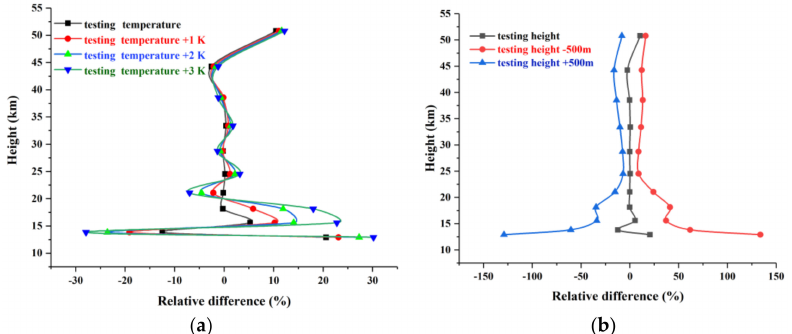
Figure 8. Relative differences between retrieval results and ACE-FTS NO 2 product under different temperature errors and different tangent height errors. ( a ) Relative differences between retrieval results and ACE-FTS NO 2 product under the conditions of exact temperature, temperature plus 1 K (red curve), temperature plus 2 K (blue curve), and temperature plus 3 K (green curve); ( b ) relative differences between retrieval results and ACE-FTS NO 2 product under the conditions of exact tangent height, tangent height minus 500 m (red curve), and tangent height plus 500 (blue curve).